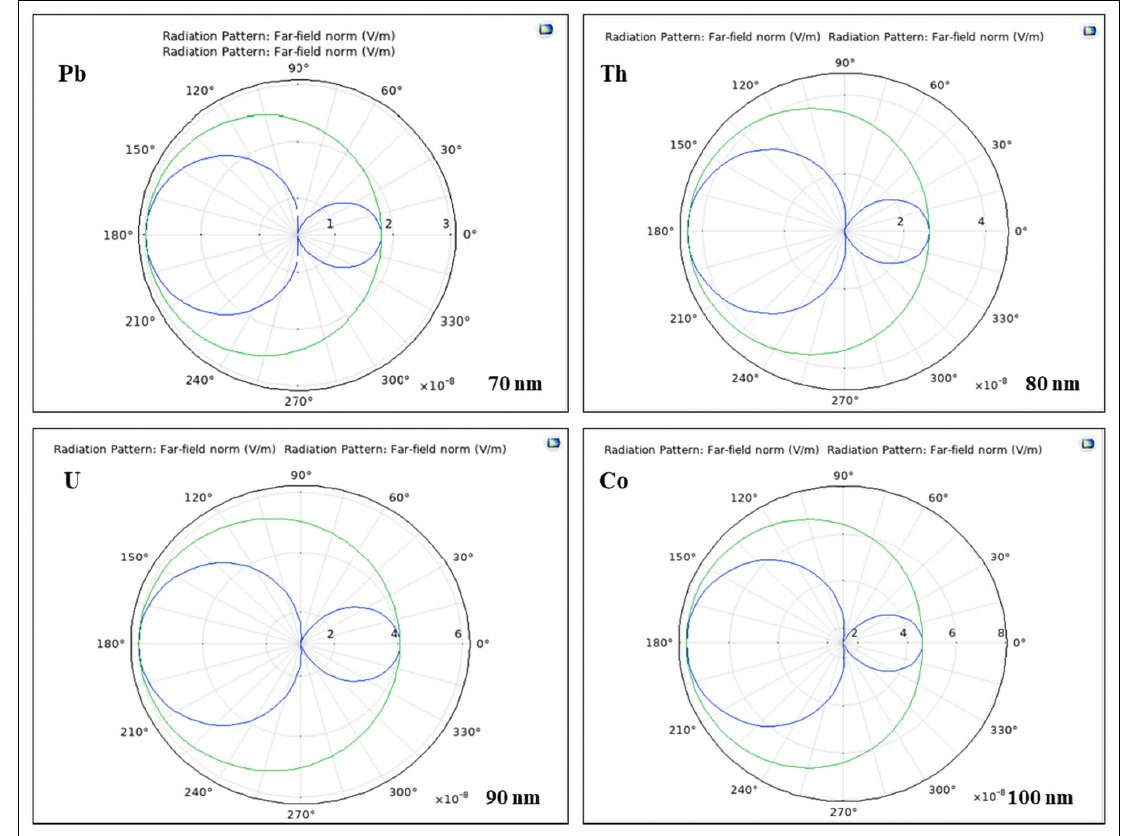
Figure 6. The far ‐ field radiation patterns of U, Pb, Co, and Th nanoparticles of diverse sizes in the E ‐ plane (blue) and H ‐ plane (green) when the wavelength is 800 nm.